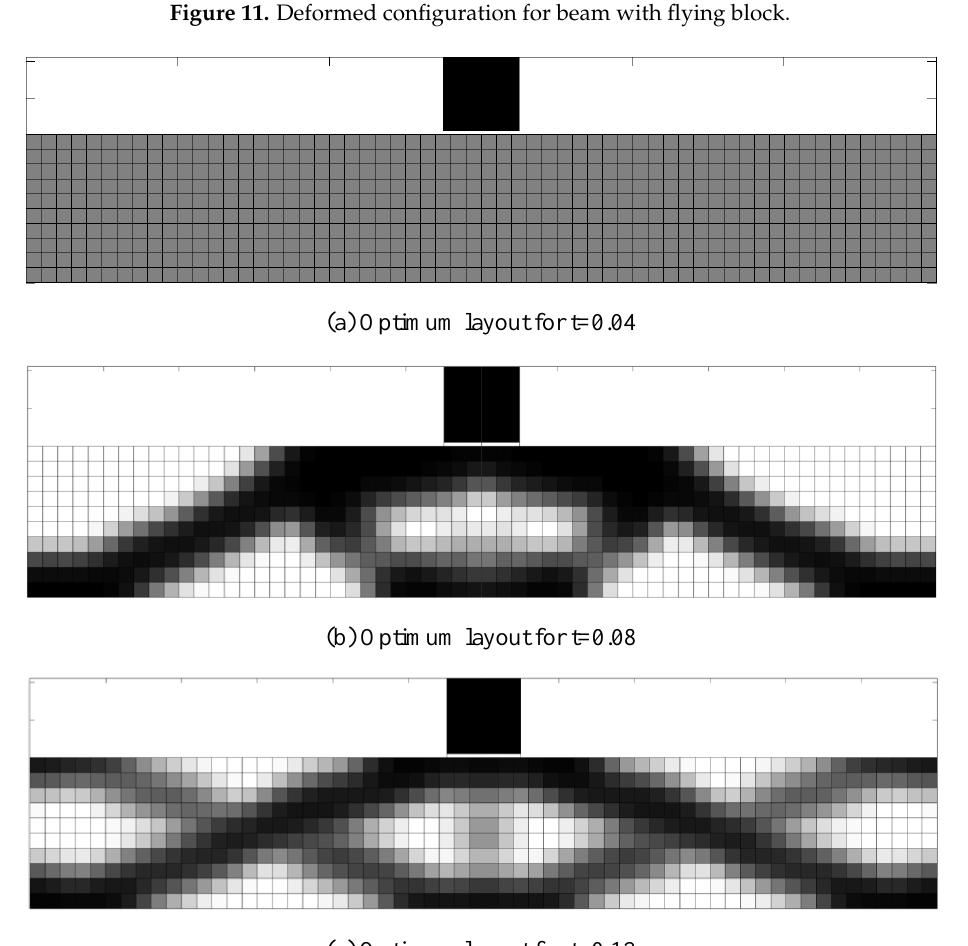
Figure 12. Optimized for beam with flying block using condensed localized mortar method.